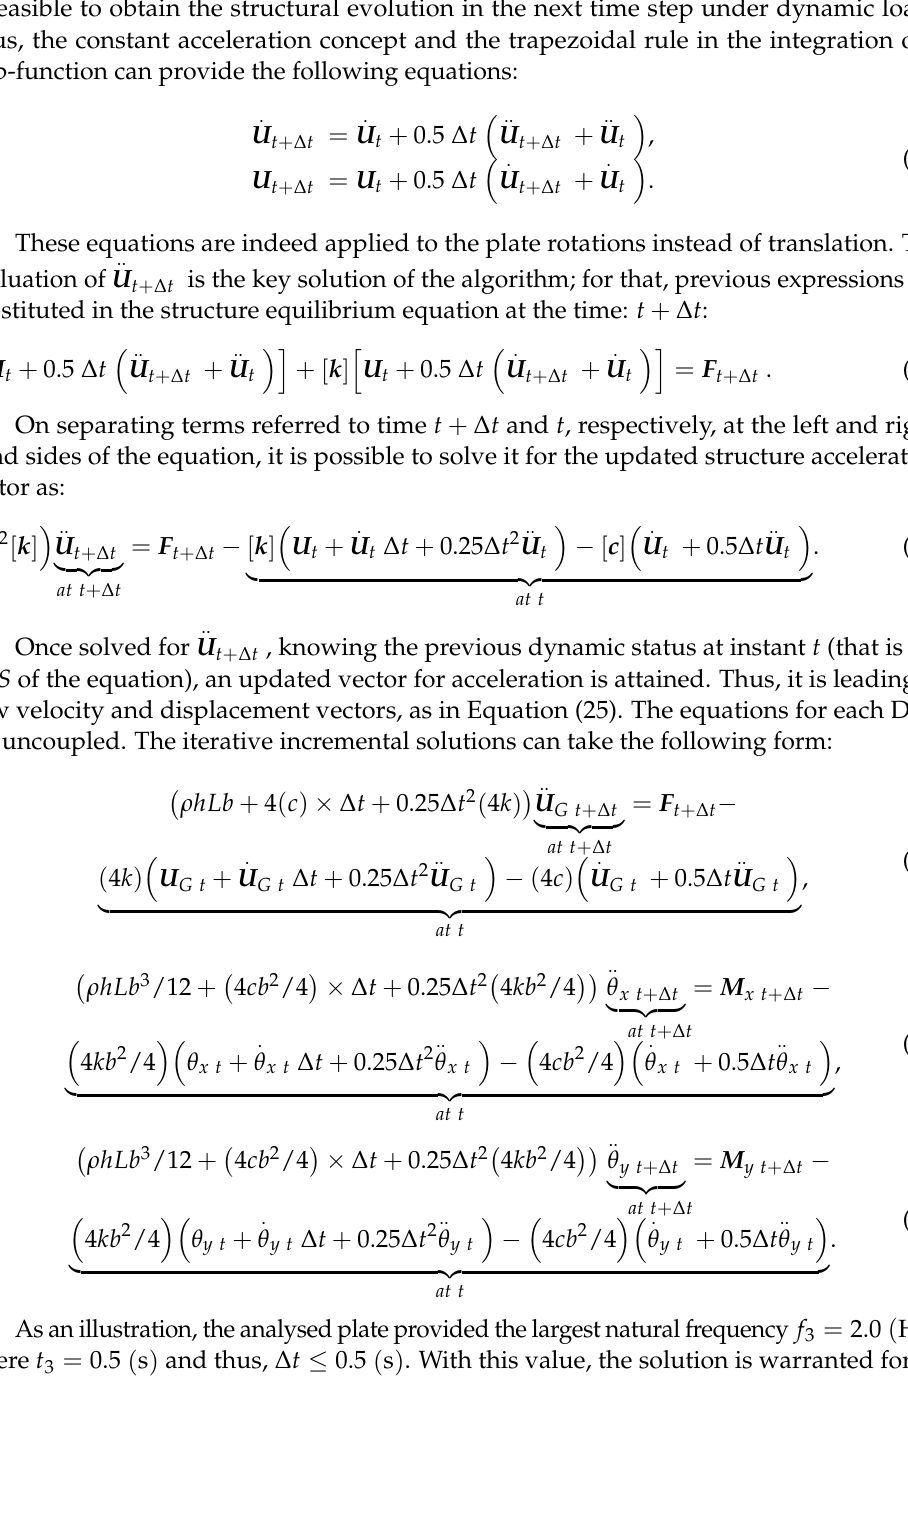
.. . U t + ∆ t , U t + ∆ t , and U t + ∆ t are accordingly the acceleration, velocity, and displacement where vectors of the structure, while F t + ∆ t is the external force vector, all at time step t + ∆ t . If velocity and displacement vectors are considered from the previous instant value, t , it is feasible to obtain the structural evolution in the next time step under dynamic